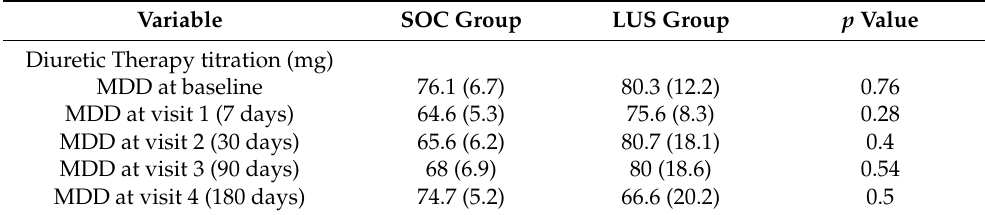
Table 1. Baseline clinical characteristics, medical treatments and LUS examination results.